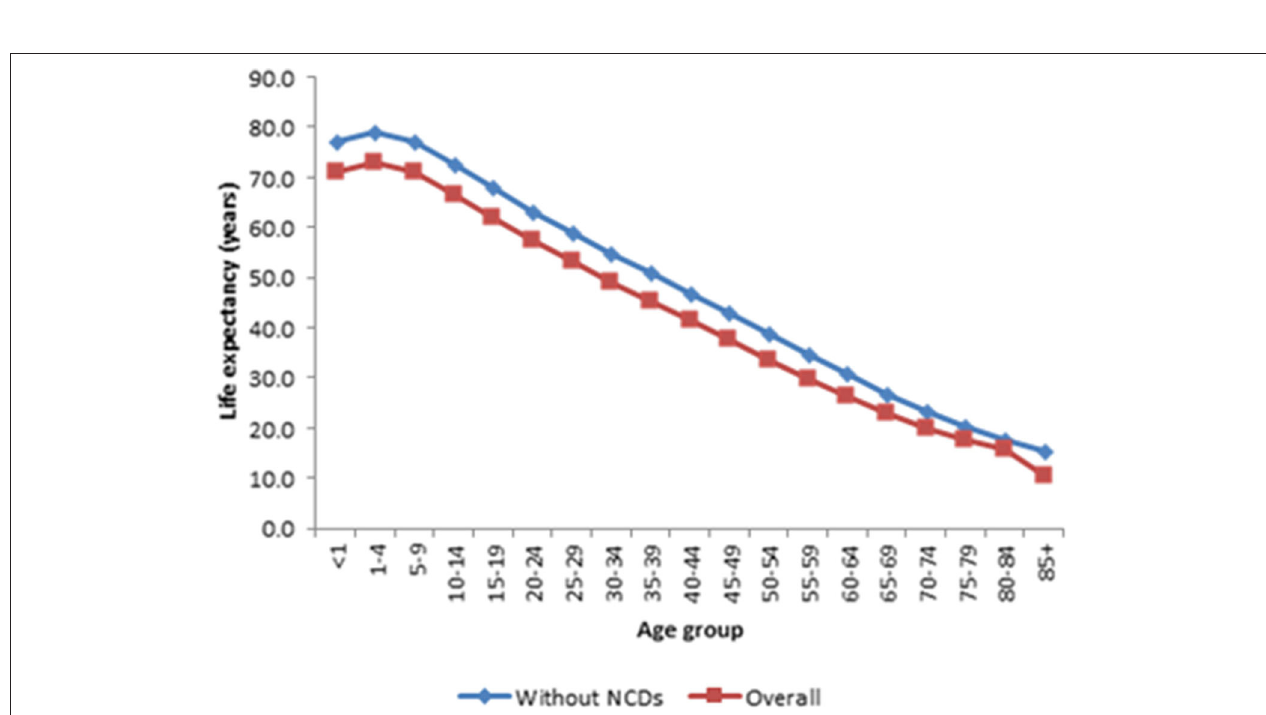
FIGURE 3 | Comparison of estimated life expectancy for each age group with all cause of death and without non-communicable diseases, Kintampo HDSS (2005–2014). Source: Kintampo HDSS (2005–2014).